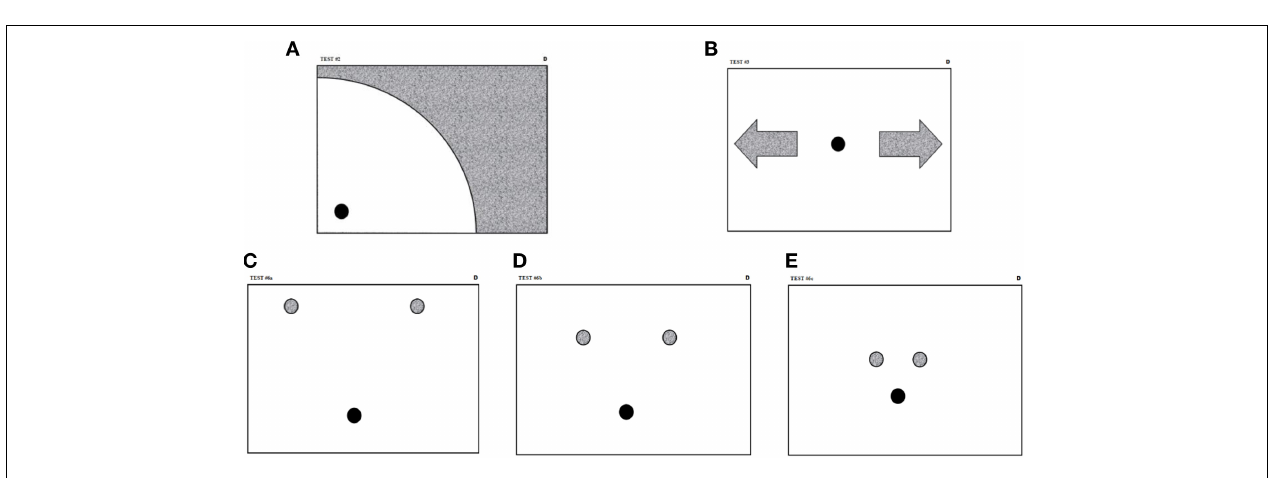
FIGURE 3 | Guiding sheets used for the simple reaction time experiments (A), the choice reaction time protocol (B), and the triangular drawings (C–E). The starting position is shown as a dark circle